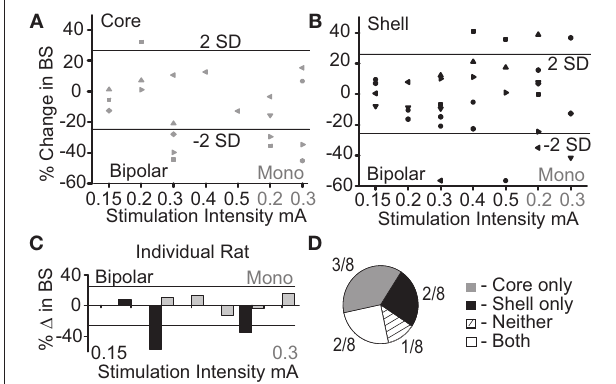
FIGURE 2 | Optimal stimulation parameters were identified that could reduce binge size (BS) using the electrode arrays targeting the NAc core and shell. (A) Titration of stimulation parameters in NAc core reveals bipolar 300 µ A and monopolar 200 µ A are both effective and roughly equivalent. Bipolar (black) and monopolar (Mono, gray) stimulation configurations with corresponding current intensities shown on x-axis. (B) Titration of stimulation parameters in NAc shell showing similar effective parameters. (C) Example of a single rat’s stimulation response profile illustrating a shell only responder (core-gray; shell-black). Horizontal lines illustrate ± 2 standard deviations ( ± 26%). (D) Distribution of stimulation response profiles for this cohort showing that